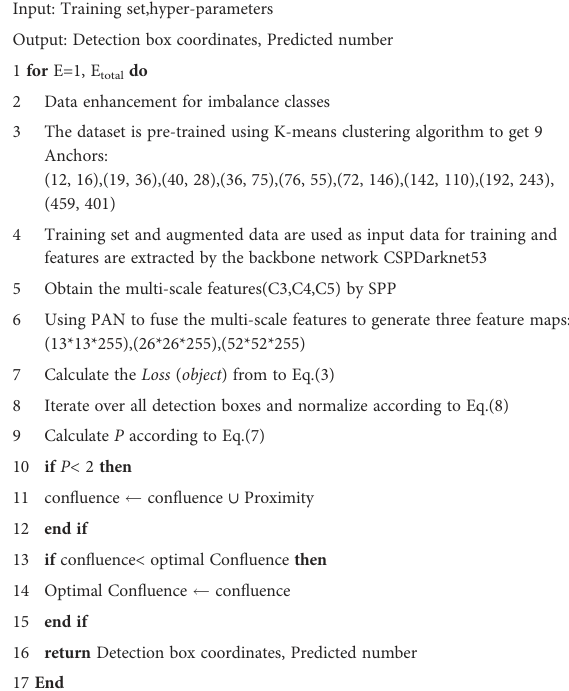
ALGORITHM 1 Pest-YOLO model.